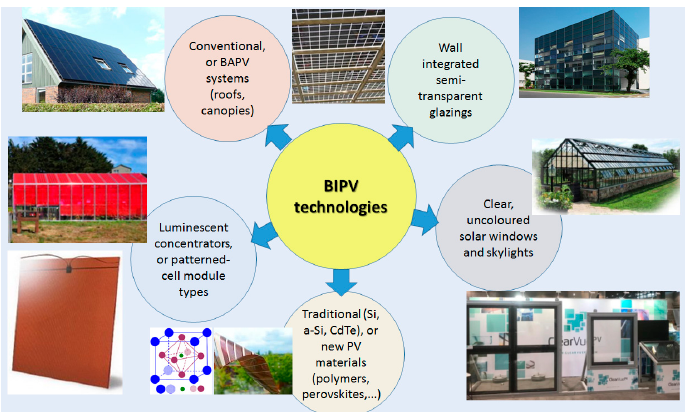
Figure 1. Building-integrated photovoltaic (BIPV) modules, technologies, applications, and materials—conventional and emergent.